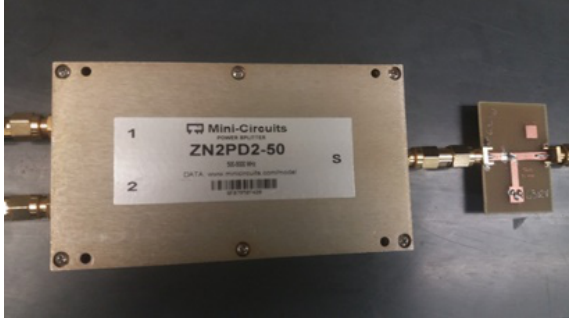
Figure 9: Photo of the Mini-circuit power splitter